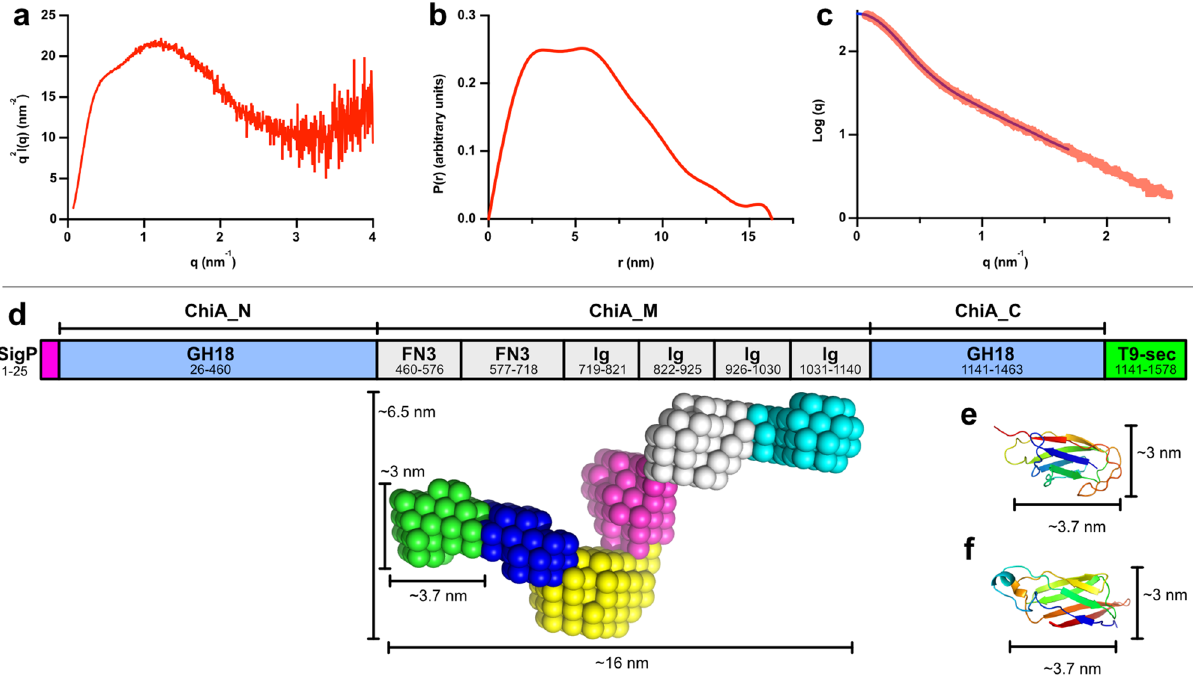
Figure 3. Small angle X-ray scattering of Fj ChiA_M. The Kratky plot (a) indicates a structured protein with some degree of flexibility while the pair distance distribution function (b) is consistent with an elongated and modular protein. (c) The fit of the ab initio envelope is shown as a blue line ( χ 2 = 1.20; generated in ATSAS as described in the methods) alongside the experimental data shown in red. (d) The domain organization of Fj ChiA, including regions predicted for the signal peptide (SigP) and type-9 secretion signal (T9-sec), shown along with the Fj ChiA_M ab initio SAXS envelope with putatively defined discrete modules uniquely colored. The Fn3-like (e) and Ig (f) domains from the pilin protein BcpA from Bacillus cereus (PDB accession 3kpt) and an antifreeze protein from Marinomonas primoryensis (PDB accession 4p99), respectively, display between 20–30% sequence identity with the putatively annotated regions in Fj